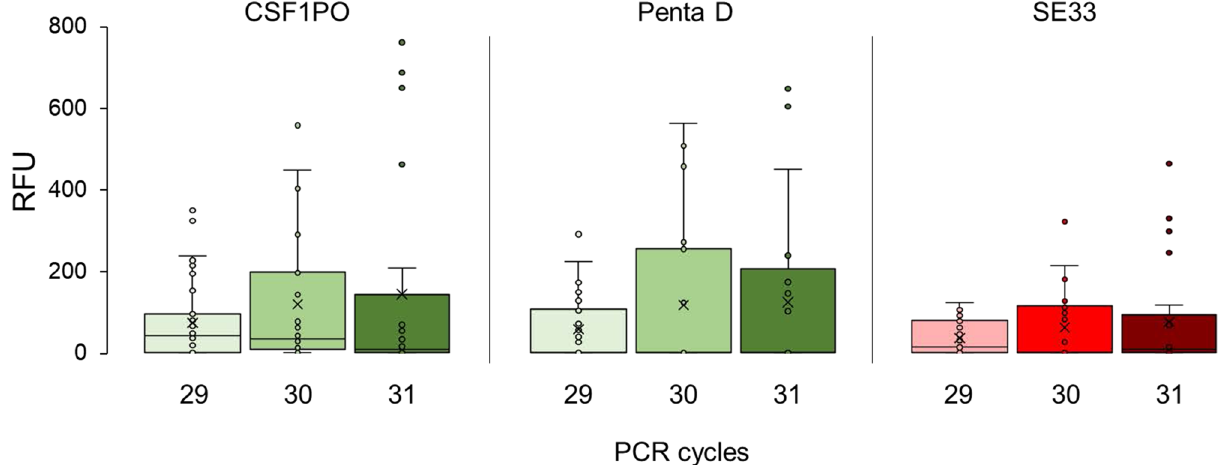
Figure 2. Locus-specific peak heights (RFU) vs. cycle number for the CSF1PO, Penta D, and SE33 loci amplified using the Promega PowerPlex Fusion 6c kit.